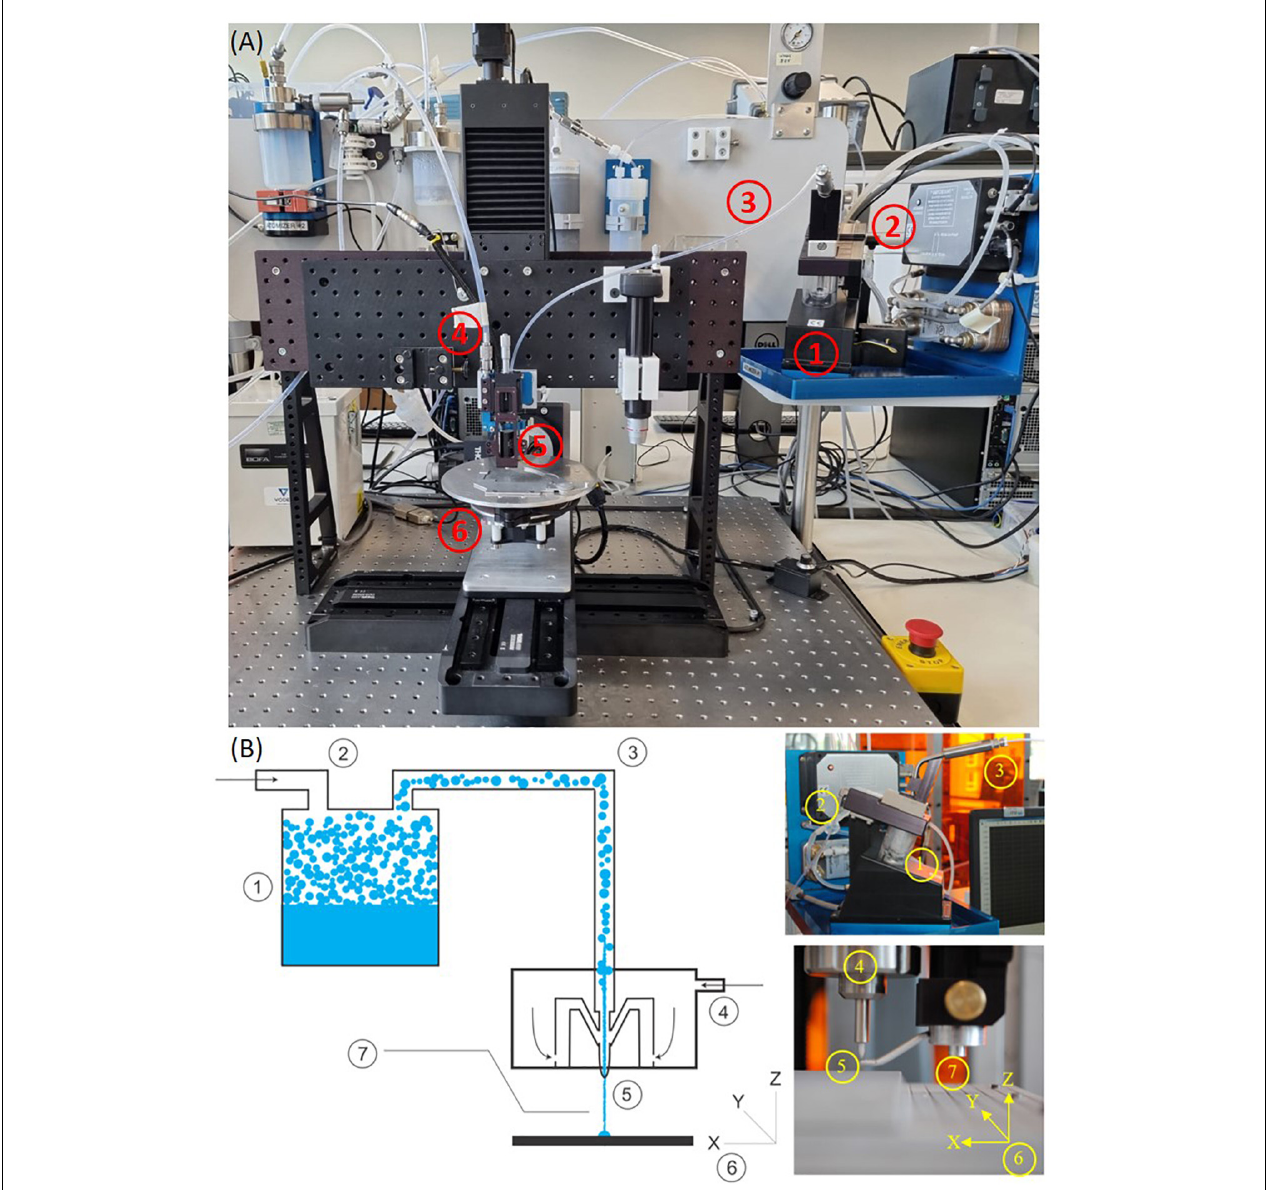
FIGURE 1 | A picture of the machine (A) and the description (B) of AJP technology. (1) A liquid sample is atomized. (2) An inert gas is used to increase the pressure in the atomizer chamber. (3) The aerosol is transported to the deposition head with the gas acting as a sheath around the aerosol. (4) The aerosol is focused and accelerated by a further annular sheath of inert gas. (5) The resulting high velocity jet is deposited onto the substrate. (6) The automated stage is moved to produce a pattern. (7) On/off patterning is achieved by interrupting the jet with a mechanical